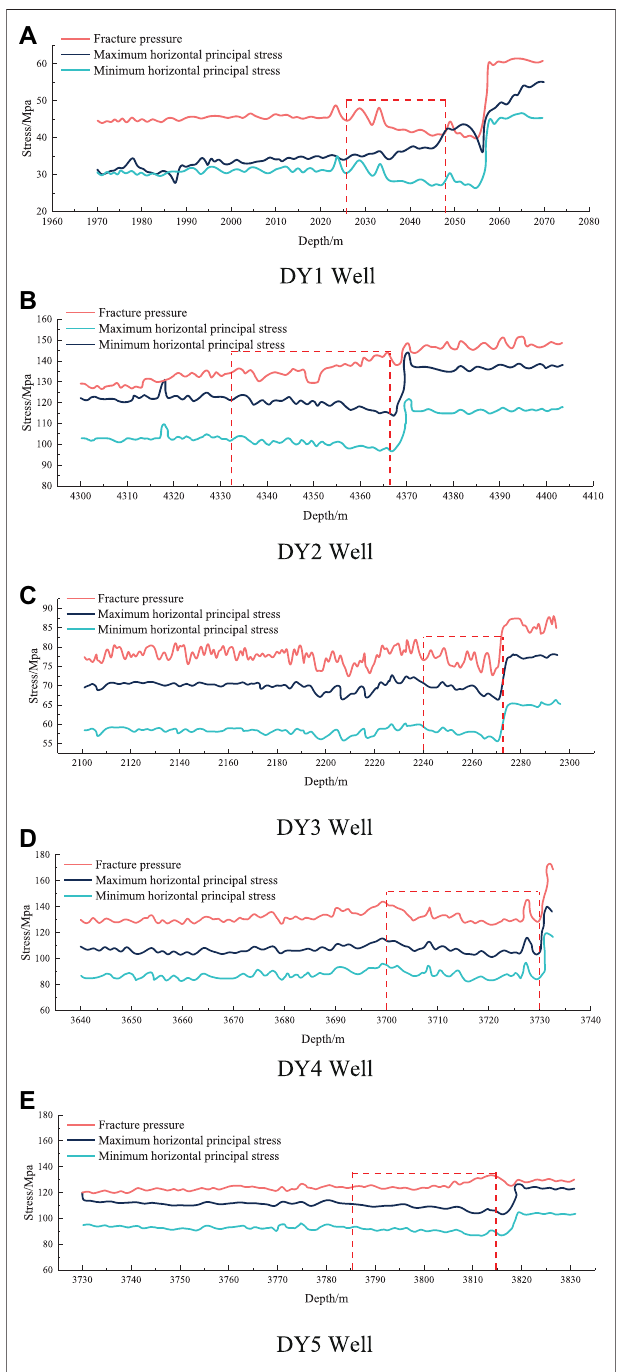
FIGURE 5 | Stress pro fi le of shale gas well of the Longmaxi formation in Dingshanarea(based onlogging interpretation results). (A) DY1 Well. (B) DY2 Well. (C) DY3 Well. (D) DY4 Well. (E) DY5 Well.